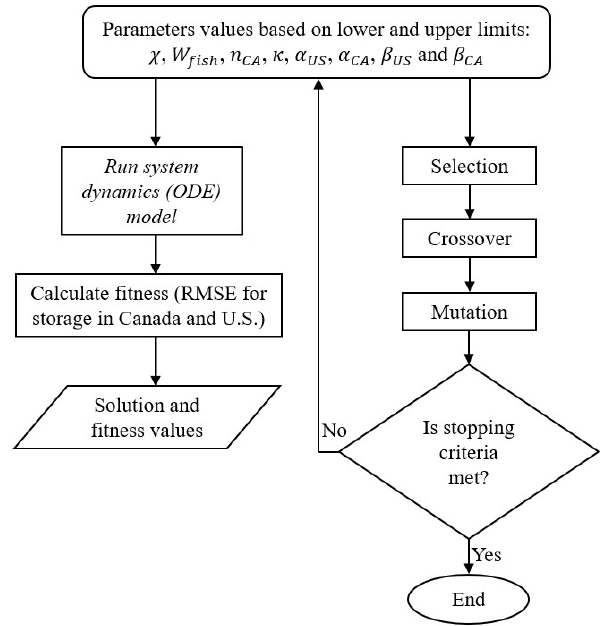
Figure 4. Overview of calibration process to optimize parameter values using the genetic algorithm. The stopping criteria include either the maximum iteration for the algorithm to run, which is set at 200 generations, or the number of iterations before the algorithm stops, in case no further optimal fitness value can be found, which is set at 70